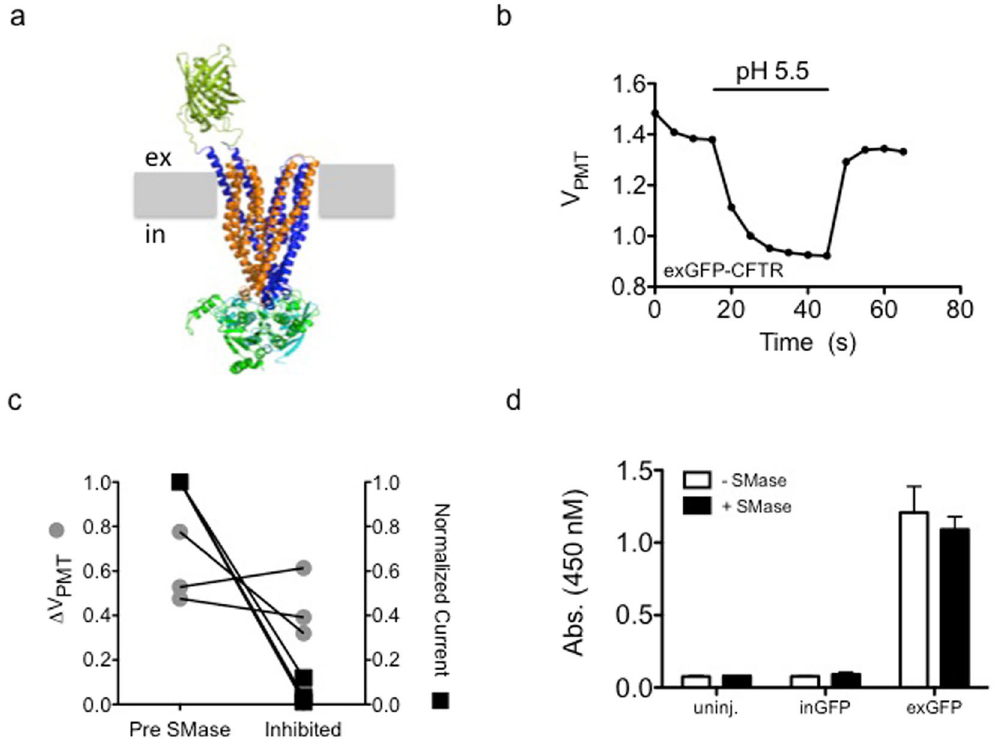
Figure 3. Channel internalization does not underlie SMase-mediated inhibition of CFTR: ( a ) Molecular model of the exGFP-CFTR protein showing the GFP tag on the extracellular side of the plasma membrane (represented in grey). ( b ) Fluorescence measured from oocytes expressing exGFP-CFTR was sensitive to a drop in extracellular pH. Representative background-subtracted voltage from the photomultiplier tube during a brief exposure to pH 5.5 recording solution is shown. ( c ) Treatment with 10 μ g/mL SMase for 10 minutes led to inhibition of currents (p = 0.0012) while the pH-dependent fluorescence change was not significantly affected (p = 0.4437, paired t-test). ( d ) In a cell-ELISA experiment, treatment with 10 μ g/mL SMase for 10 minutes did not change the accessibility of the extracellular GFP on exGFP-CFTR to an anti-GFP antibody. Uninjected cells and cells expressing inGFP-CFTR showed minimal signal (n =